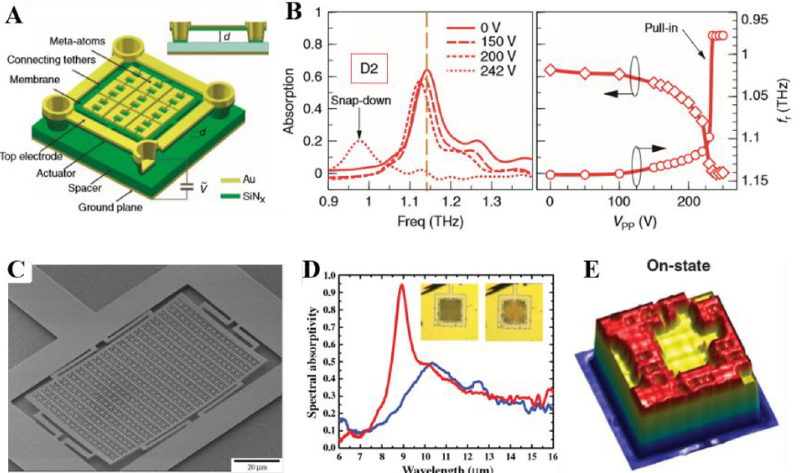
Figure 8: (A). Schematic of the THz tunable electric split-ring resonators (ESRRs).